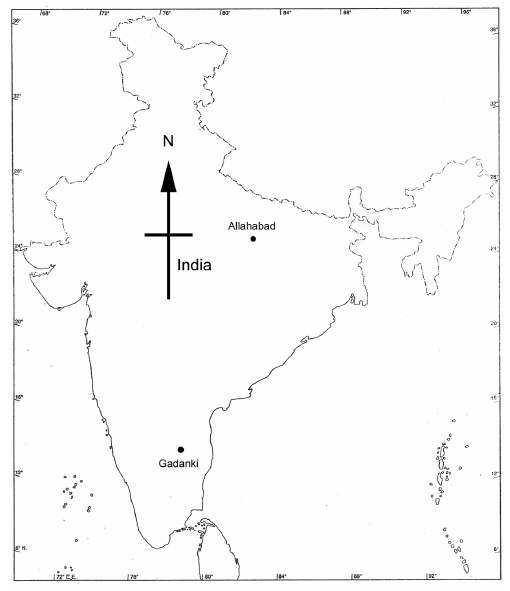
Figure 1. Location of Allahabad and Gadanki in the Indian subcon- tinent.